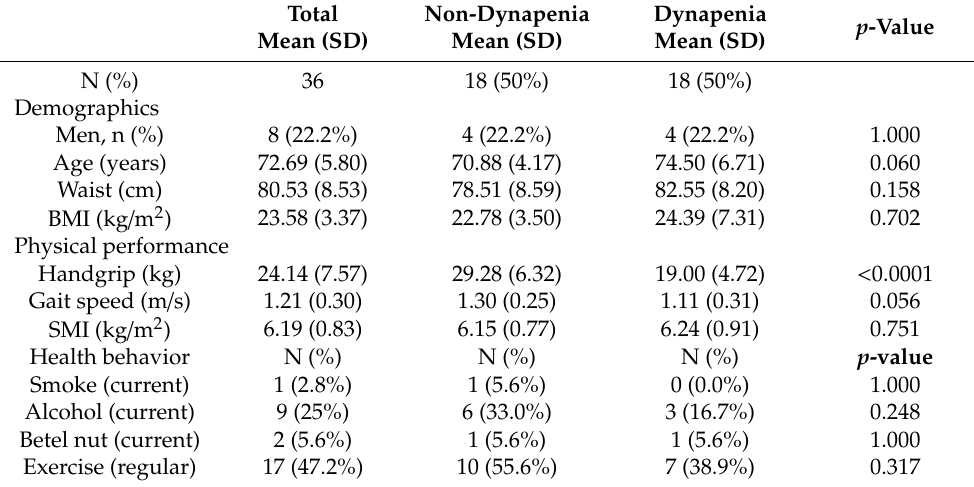
Table 1. Basic demographics characteristics.